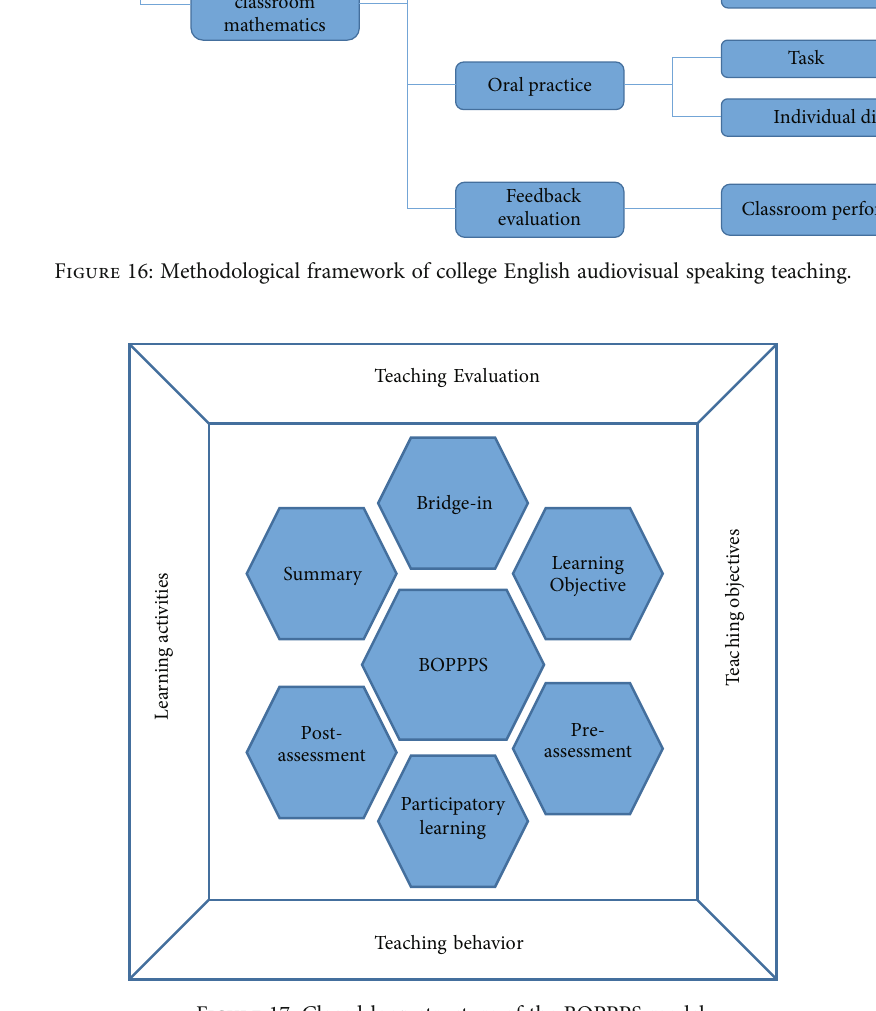
Figure 17: Closed-loop structure of the BOPPPS